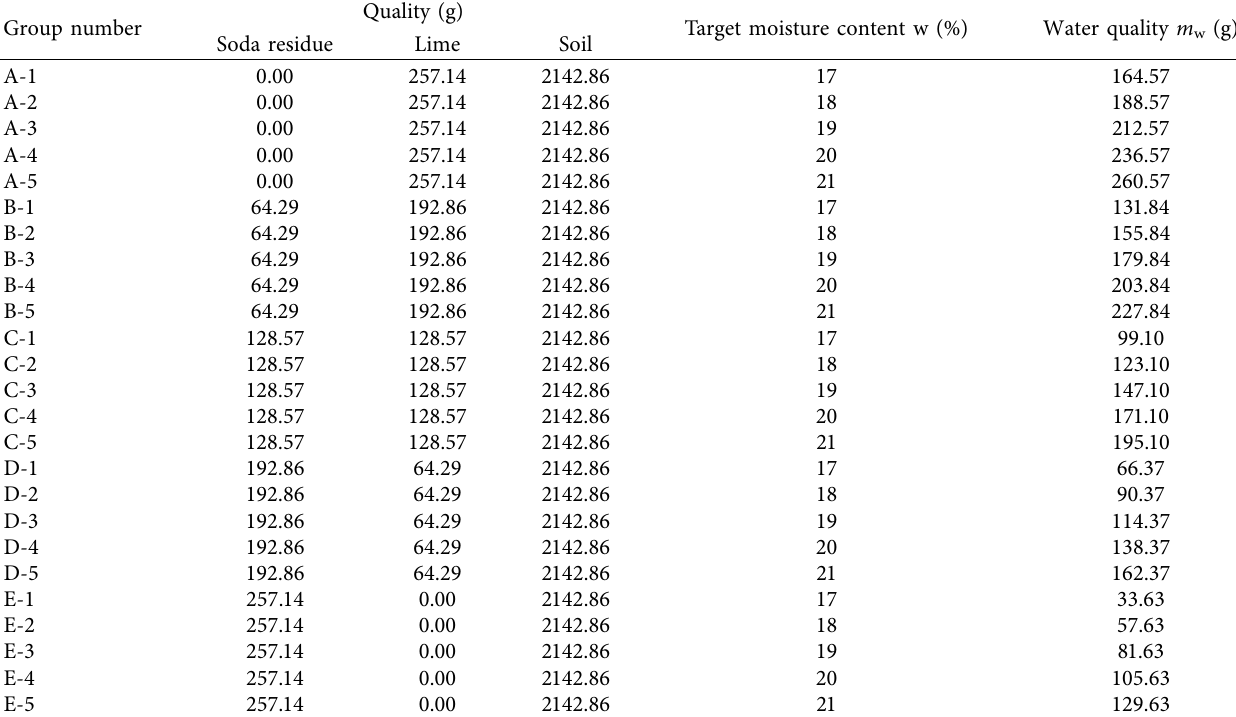
Table 3: Compaction test scheme and mass